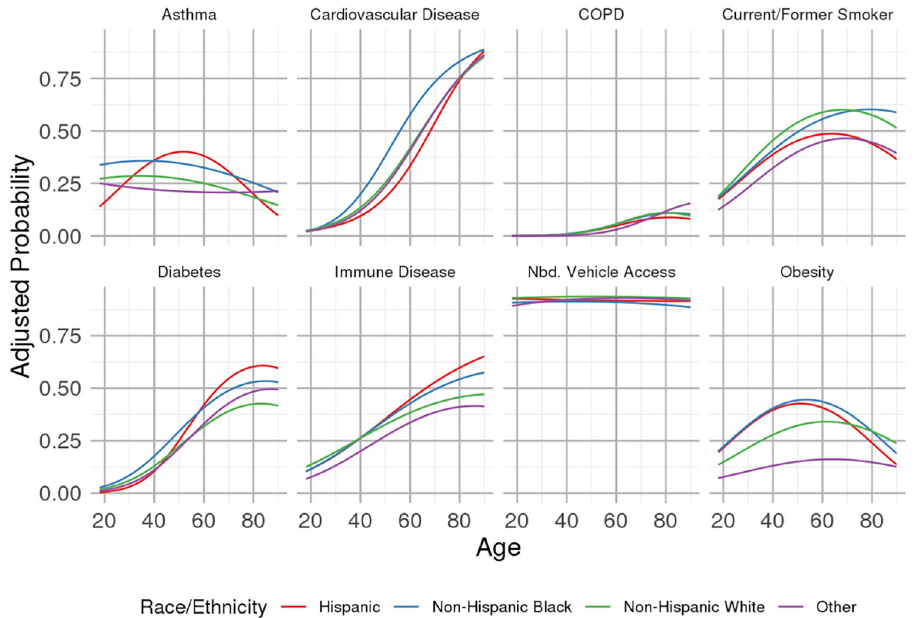
Fig 2. Prevalence of selected comorbid conditions and proportion of households in patients’ respective neighborhood of residence owning at least one vehicle, as a function of age, for groups of patients defined according to race and ethnicity. Estimates adjusted to the observed median neighborhood income of $69,324. Estimates for cardiovascular disease adjusted to modal values of other predictors in the model, i.e., non-diabetic, non- obese, no autoimmune disease, and no documented smoking history. Similarly, estimates for COPD adjusted to no documented smoking history.